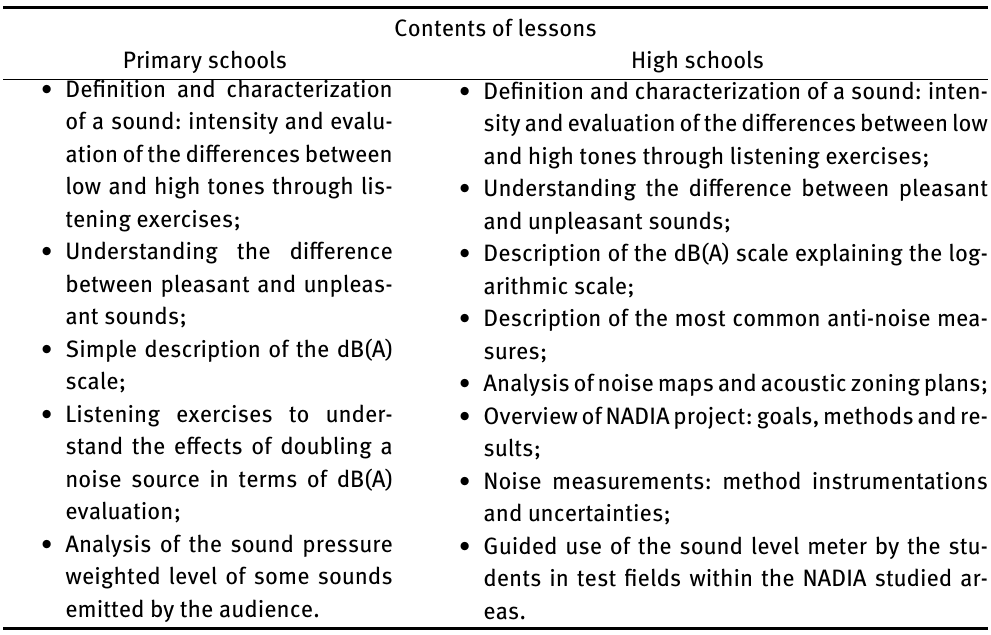
Table 10: Contents of lessons for pupils carried out within the NADIA